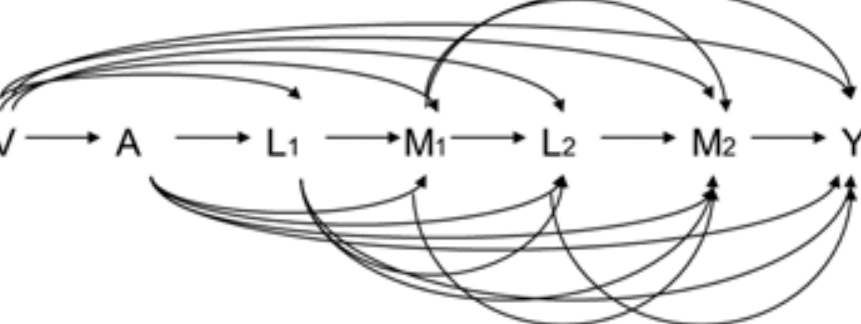
Figure 1: Causal diagrams for a setting with two mediators and time-varying mediator-outcome confounders affected by